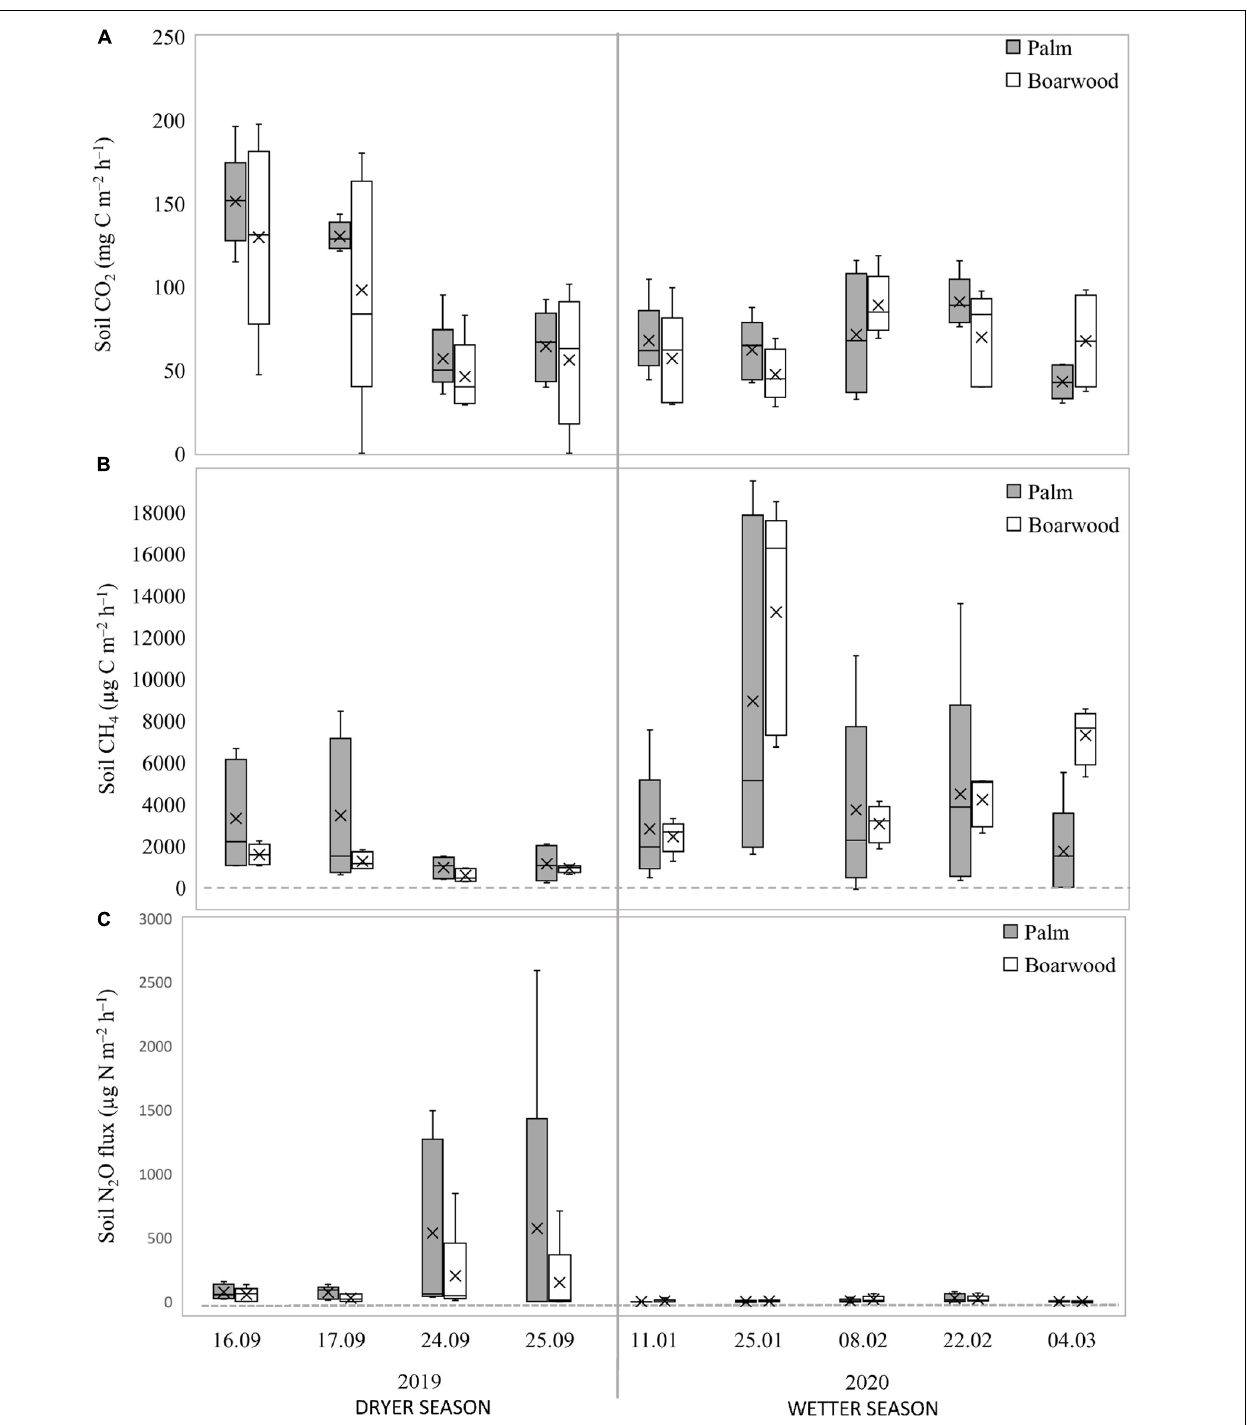
FIGURE 2 | Temporal variation of average soil CO 2 (A) , CH 4 (B) , and N 2 O (C) fluxes. Median (dash line inside the box), average (cross inside the box), 25 and 75% quartiles (lower and higher lines of the box), min and max values (whiskers) are shown.